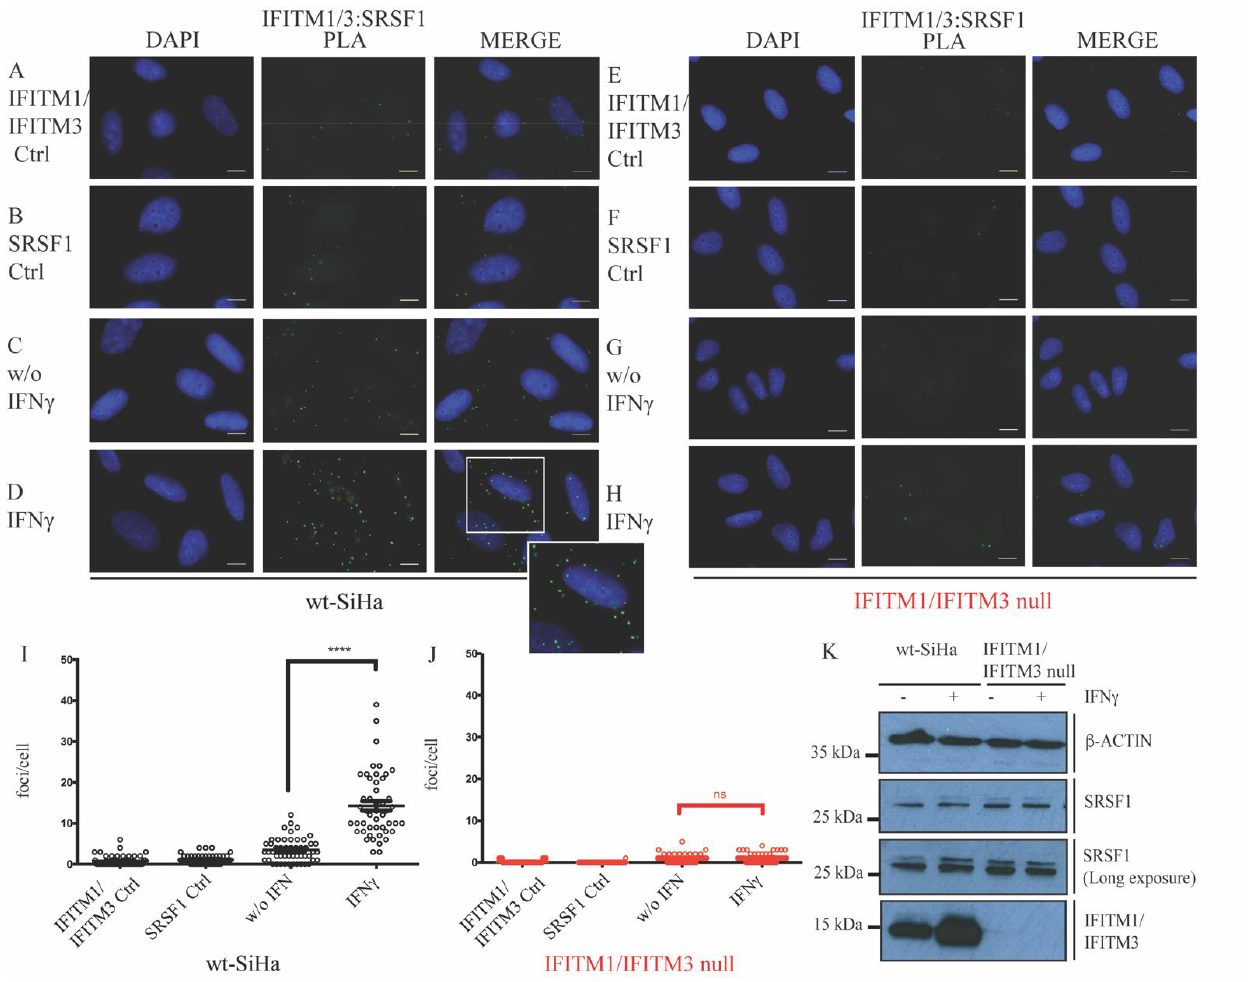
Figure 1. Evaluation of the IFITM1/IFITM3:SRSF1 protein – protein expression and interaction in situ after stimulation with IFNγ. Proximity ligation assays were used to study the endogenous interaction between SRSF1 and IFITM1/3 proteins in wt-SiHa ( A – D ) and IFITM1/IFITM3 null cells ( E – H ). IFITM1/3:SRSF1 PLA images identify the protein – protein association foci (depicted in green) and DAPI was used for nuclear staining (depicted in blue). ( A , B , E , F ) Cells were incubated as negative controls using IFITM1/IFITM3 or SRSF1 antibodies only. ( C , G ) Cells were incubated with both IFITM1/IFITM3 and SRSF1 antibodies to define protein – protein foci in nonstimulated cells. ( D , H ) Cells were incubated with both IFITM1/IFITM3 and SRSF1 antibodies to define protein – protein foci in IFNγ -stimulated cells. Magnification of selected area at the bottom right of merge ( D ). Representative quantification of the protein – protein interaction foci per cell in pres- ence or absence of IFNγ stimulation in wt -SiHa cells ( I ) and IFITM1/IFITM3 null cells ( J ). At least 50 cells were counted in each condition. Statistical study was performed with one-way ANOVA and Bonferroni correction (**** p < 0.0001; ns, not significant). n = 3 . Scale bar: 10 μm. ( K ) Immunoblots examining the endogenous levels of SRSF1 protein in nonstimulated or IFNγ -stimulated wt-SiHa cells or IFITM1/IFITM3 null cells.